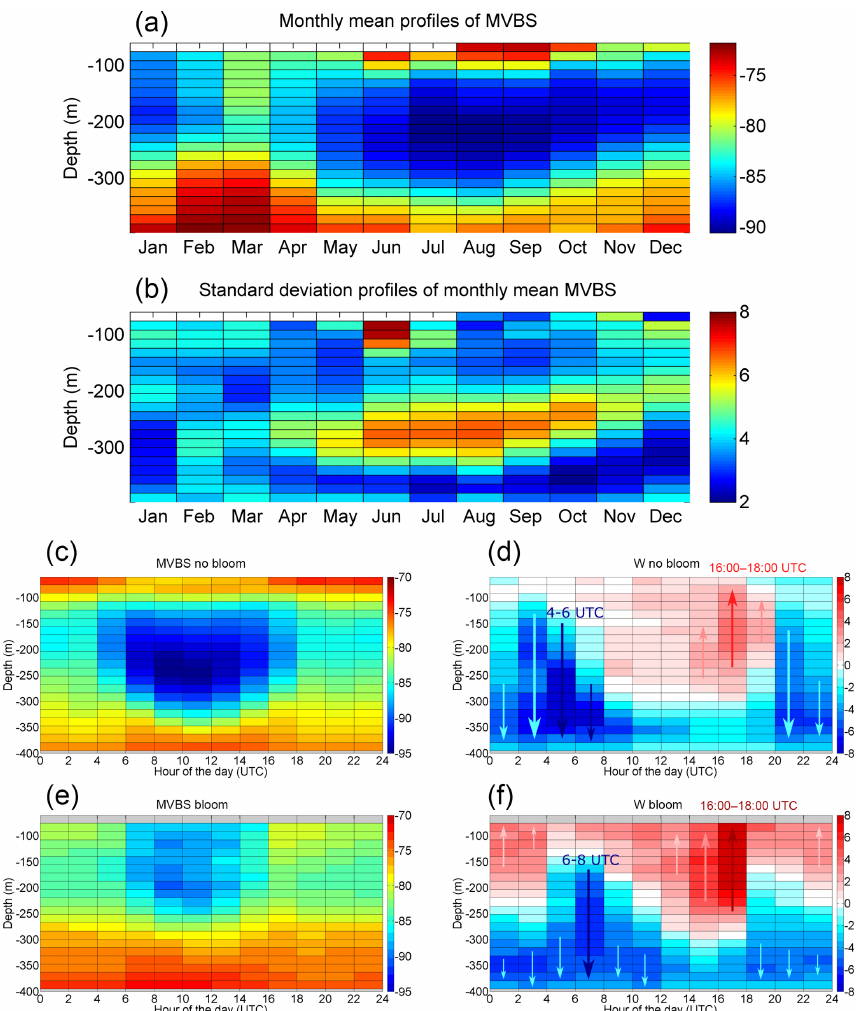
Figure 4. Monthly mean (a) vertical MVBS profiles (dB re(4 π m) − 1 ) and their standard deviation (b) ; (c–d) mean MVBS dB re(4 π m) − 1 ) and W (mms − 1 ) during zooplanktonic non-blooming periods (approximately between May and November) as a function of depth (m) and hour of the day; (e–f) mean MVBS (dB re(4 π m) − 1 ) and W (mms − 1 ) during zooplanktonic blooming periods (approximately between December and April) as a function of depth (m) and hour of the day. Bluish and reddish arrows in (d) and (f) indicate main downward and upward motions, respectively. The time span of the most evident downward and upward events is given in (d) and (f)